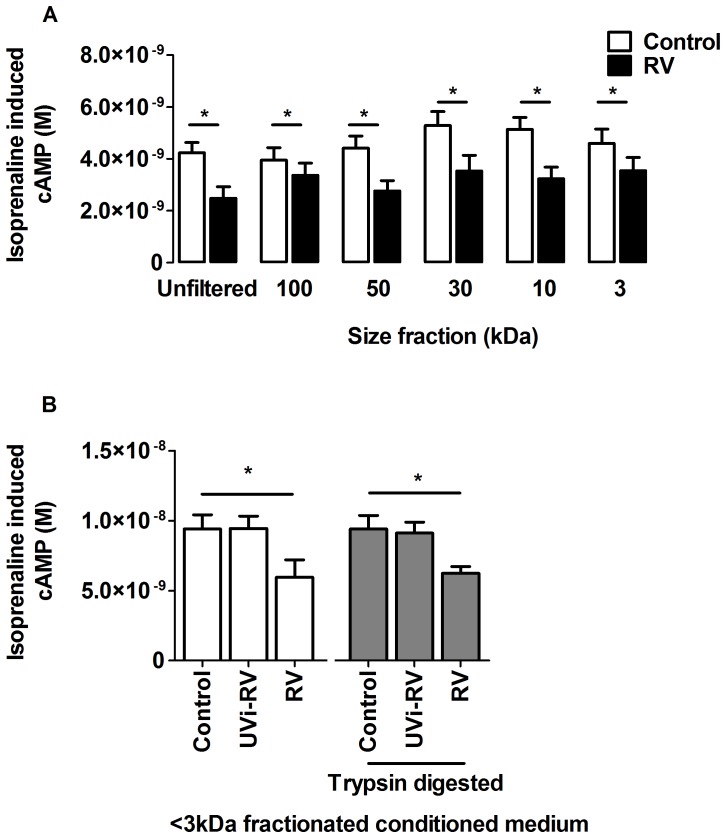
Size fractionation and trypsin digestion of HBEC conditioned medium still resulted in RV-induced β2 adrenoceptor desensitization on ASMCs.HBEC (n = 6) were uninfected (Control) or infected with replication competent RV (RV) at an MOI = 2 for 24 hours to generate conditioned medium. The conditioned medium was pooled and serially fractionated through ultrafilters with molecular weight cut offs ranging from 100-3 kDa. Alternatively, conditioned medium from HBEC (n = 3) that was uninfected (Control) or exposed to: UV inactivated RV (UVi-RV) or replication competent RV (RV) at an MOI = 2 for 24 hours was digested in the presence of 500 µg/mL of trypsin for 24 hours at 37°C and trypsin removed using a 3 kDa MWCO ultrafilter. ASMCs (n = 6) were then treated with unfiltered or size fractionated control or RV-induced conditioned medium (A) or 3 kDa fractionated conditioned medium which was undigested or digested with trypsin (B) for 3 days. Isoprenaline induced cAMP was measured using a cAMP functional assay. Data represent mean ± SEM. Statistical differences were detected using multiple paired Student’s t-tests (A) or a 1-way ANOVA with Bonferroni post test (B) comparisons to control conditioned medium *p<0.05.